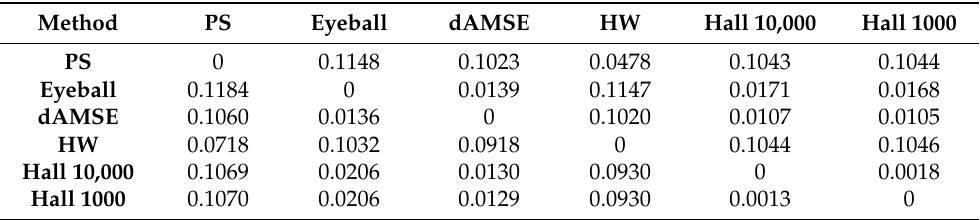
Table 6. The root mean squared differences (RMSE) of the threshold estimates in the left tail (below diagonal) and right tail (above diagonal) for five